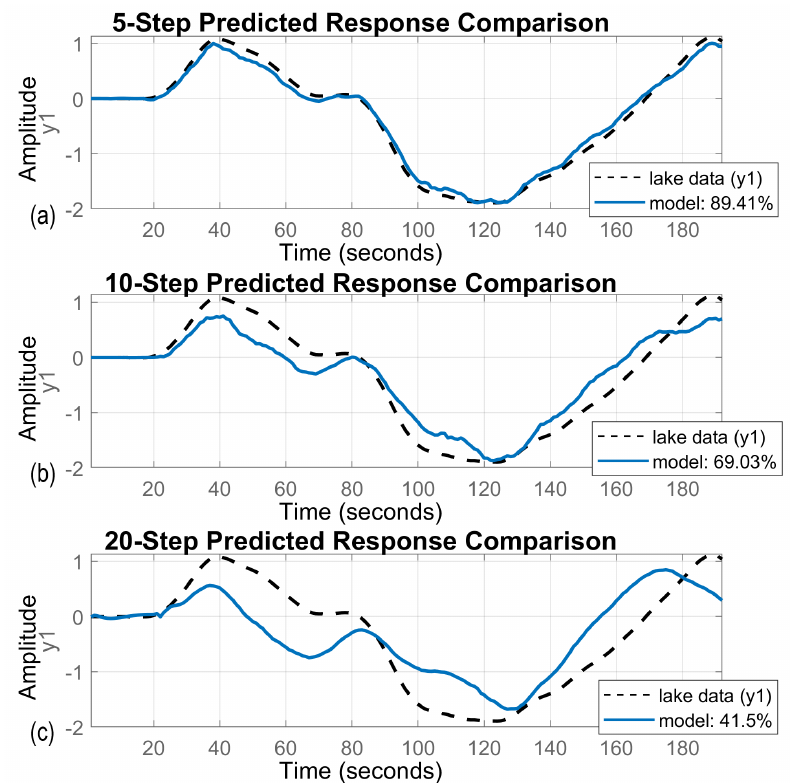
Figure 10. Regularized GA model: 5-, 10-, and 20-step prediction comparisons based on real- time lake validation data; ( a ) 5-steps ahead prediction, ( b ) 10-steps ahead prediction, ( c ) 20-steps ahead